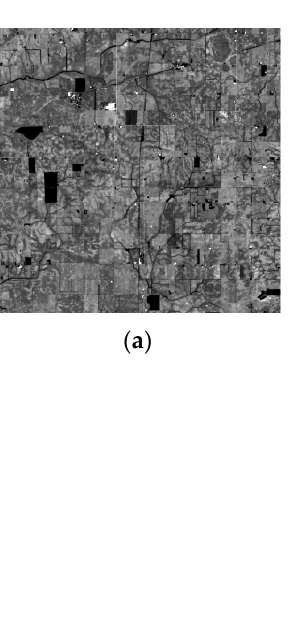
Figure 5. Population of Indiana ( a ), Chicago ( b ), and simulated population of Georgia ( c ) and their histograms.